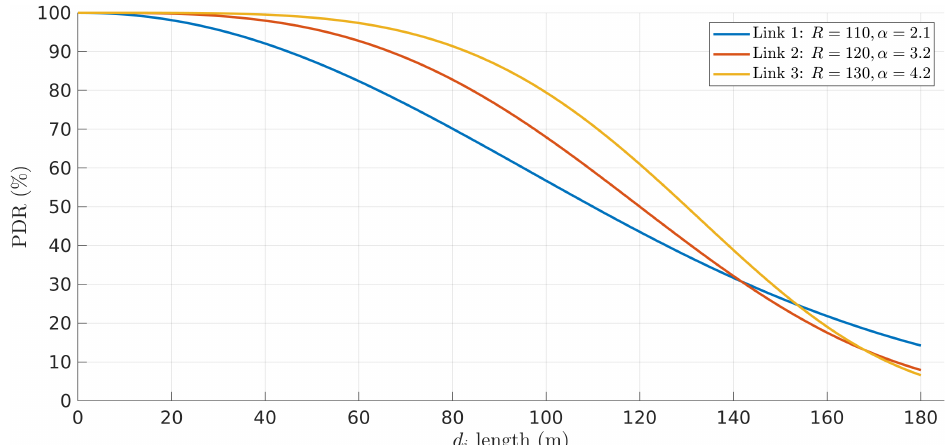
Figure 4. PDR of link 1, link 2, and link 3 as a function of their